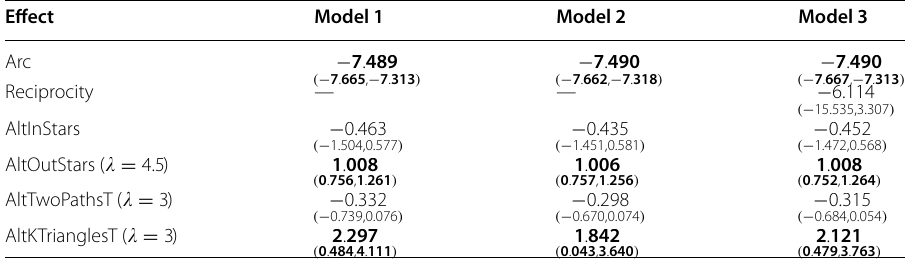
Parameter estimates that are statistically significant are shown in bold. In Model 1 only, estimation is conditional on no reciprocated arcs, even though there is a single reciprocated arc in the data. Model 3 is included for illustration, even though it shows poor convergence with respect to the Reciprocity parameter (t-ratio magnitude is greater than